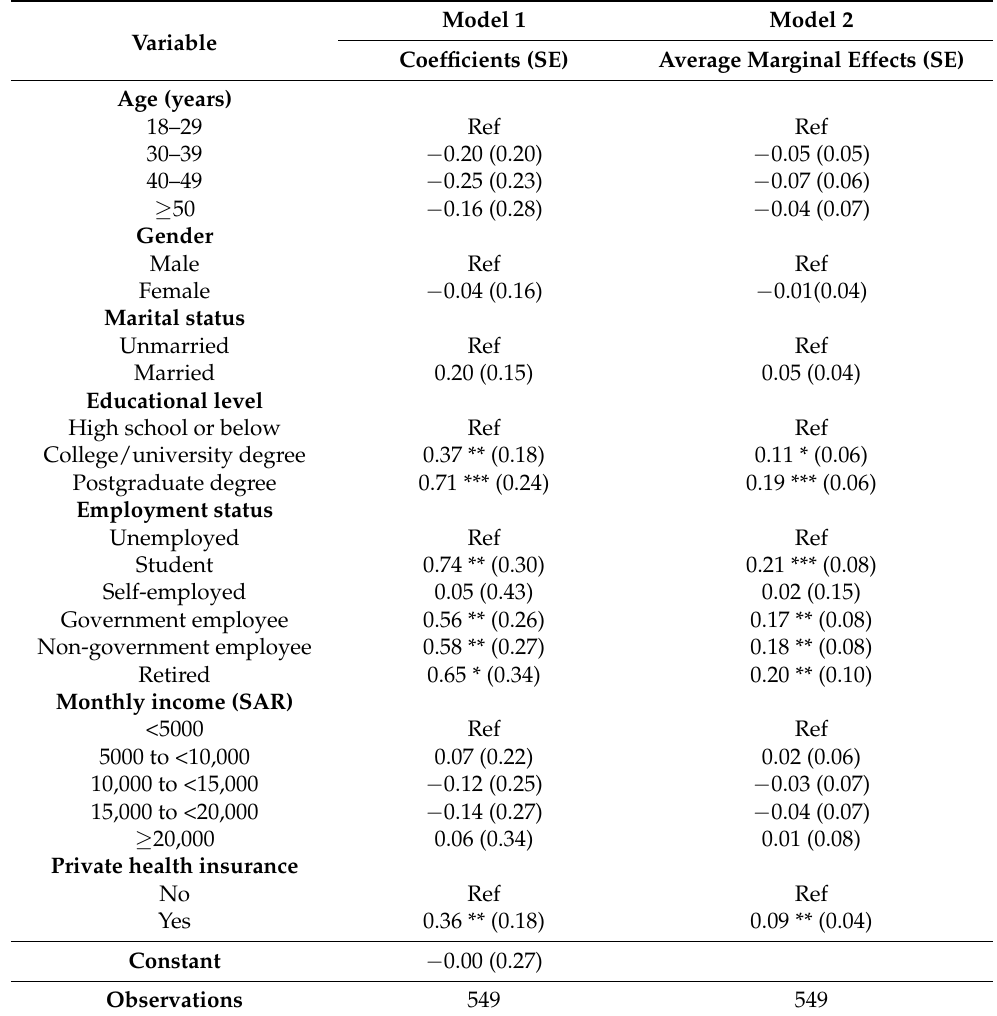
Table 4. Socioeconomic determinants of willingness to pay for immediate public dental